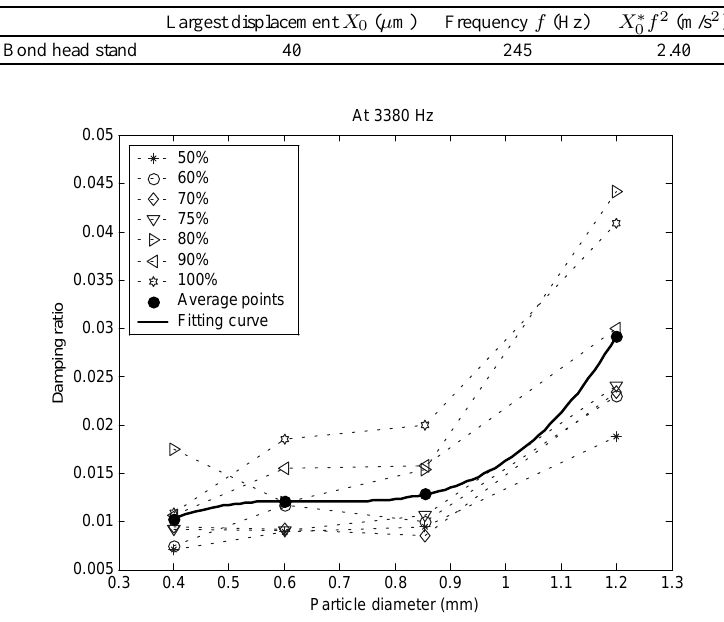
Fig. 13. Damping ratio vs. particle diameter for different packing ratios at 3380